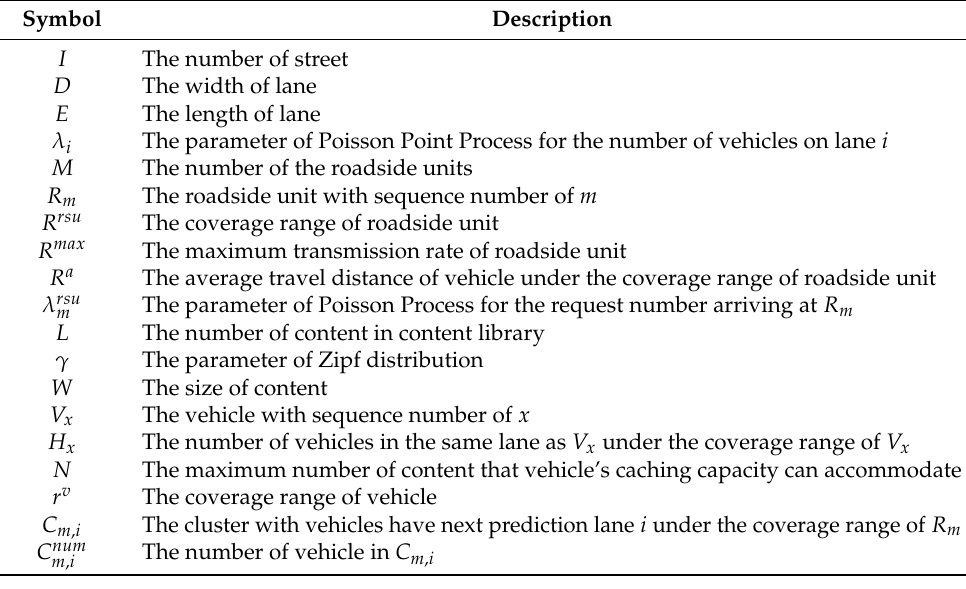
Table 1. The definitions of common